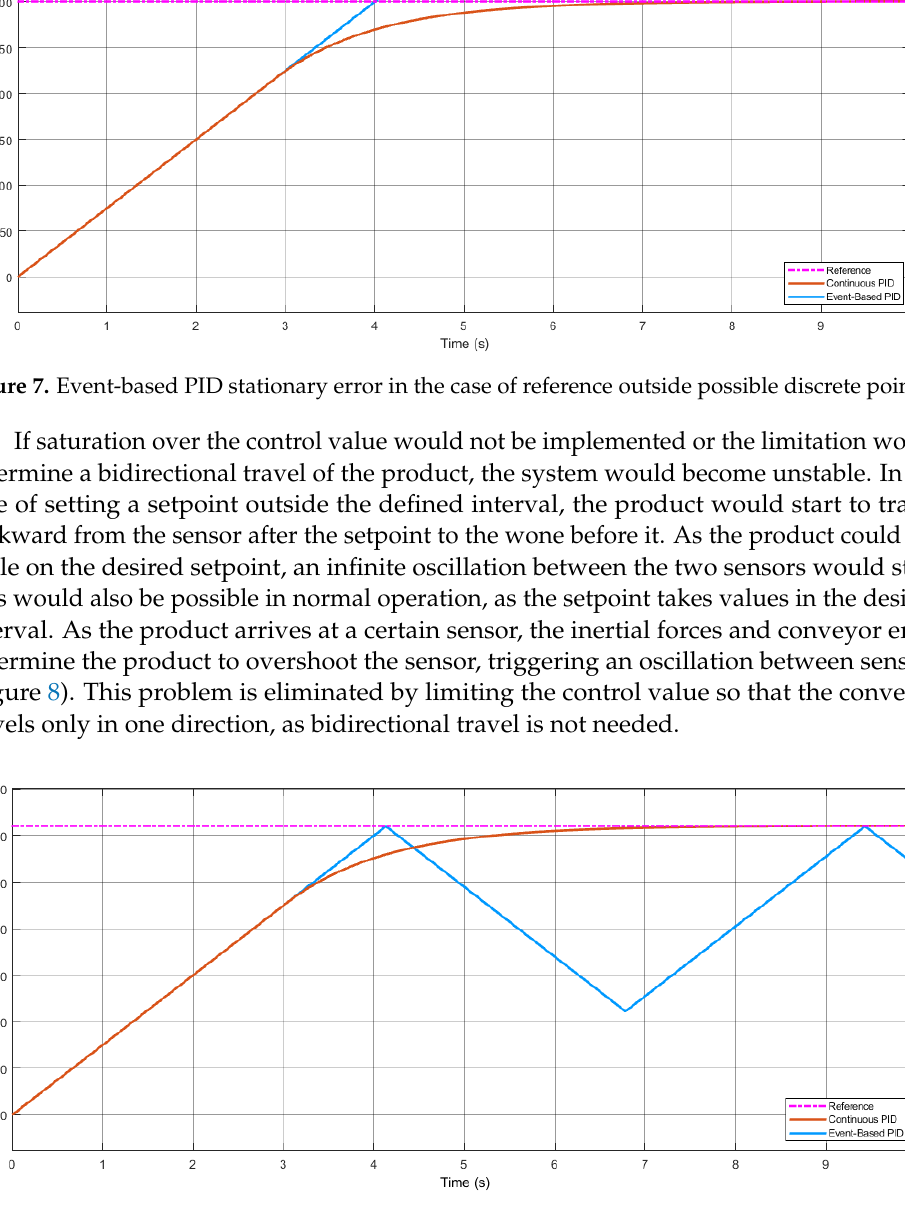
Figure 8. Event-based PID oscillations in the case of negative output signal limits (conveyor moving backward). moving